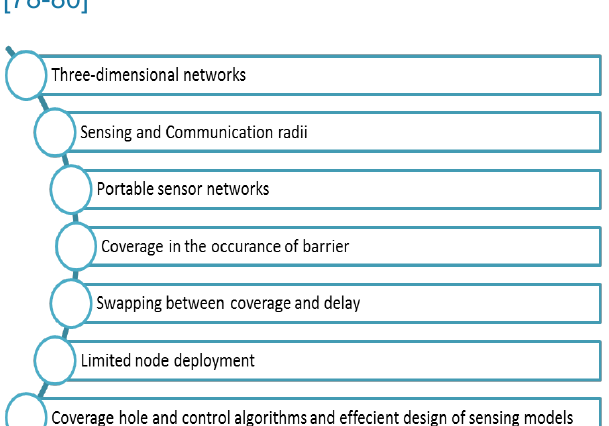
Figure 2. Open problems and research challenges in